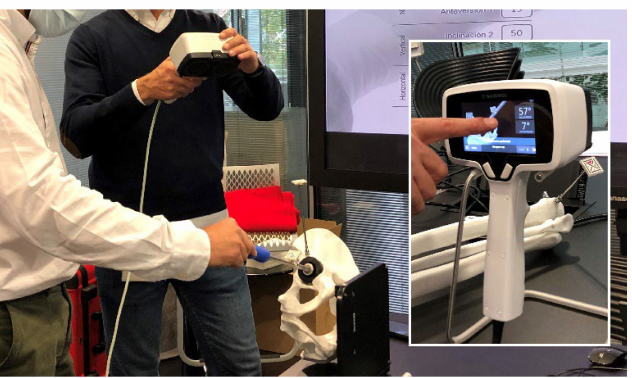
Figure 2. One of the volunteers performing the test. In the square, the navigator providing informa- tion on inclination and